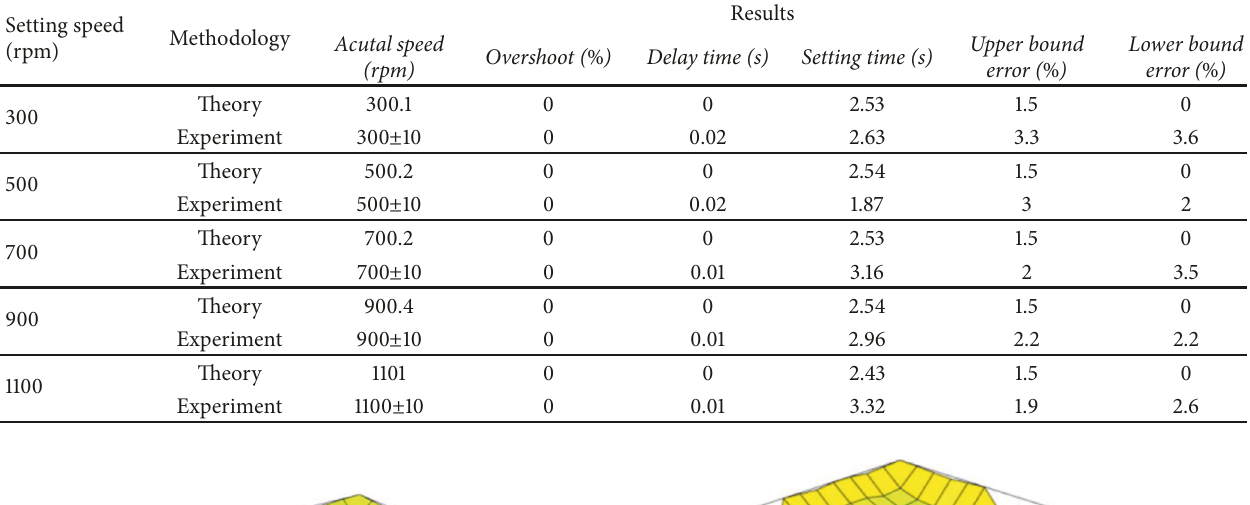
Table 5: Theoretical and experimental results.